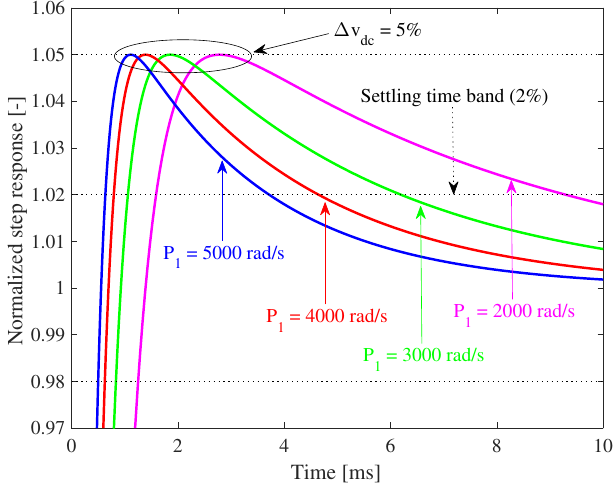
Figure 8. Simulation of G dc ( s ) for m = 0.0765 to ensure that ∆ v dc =